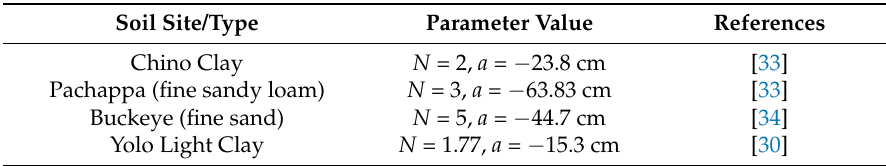
Table 1. Soil parameters used on the modified Gardner